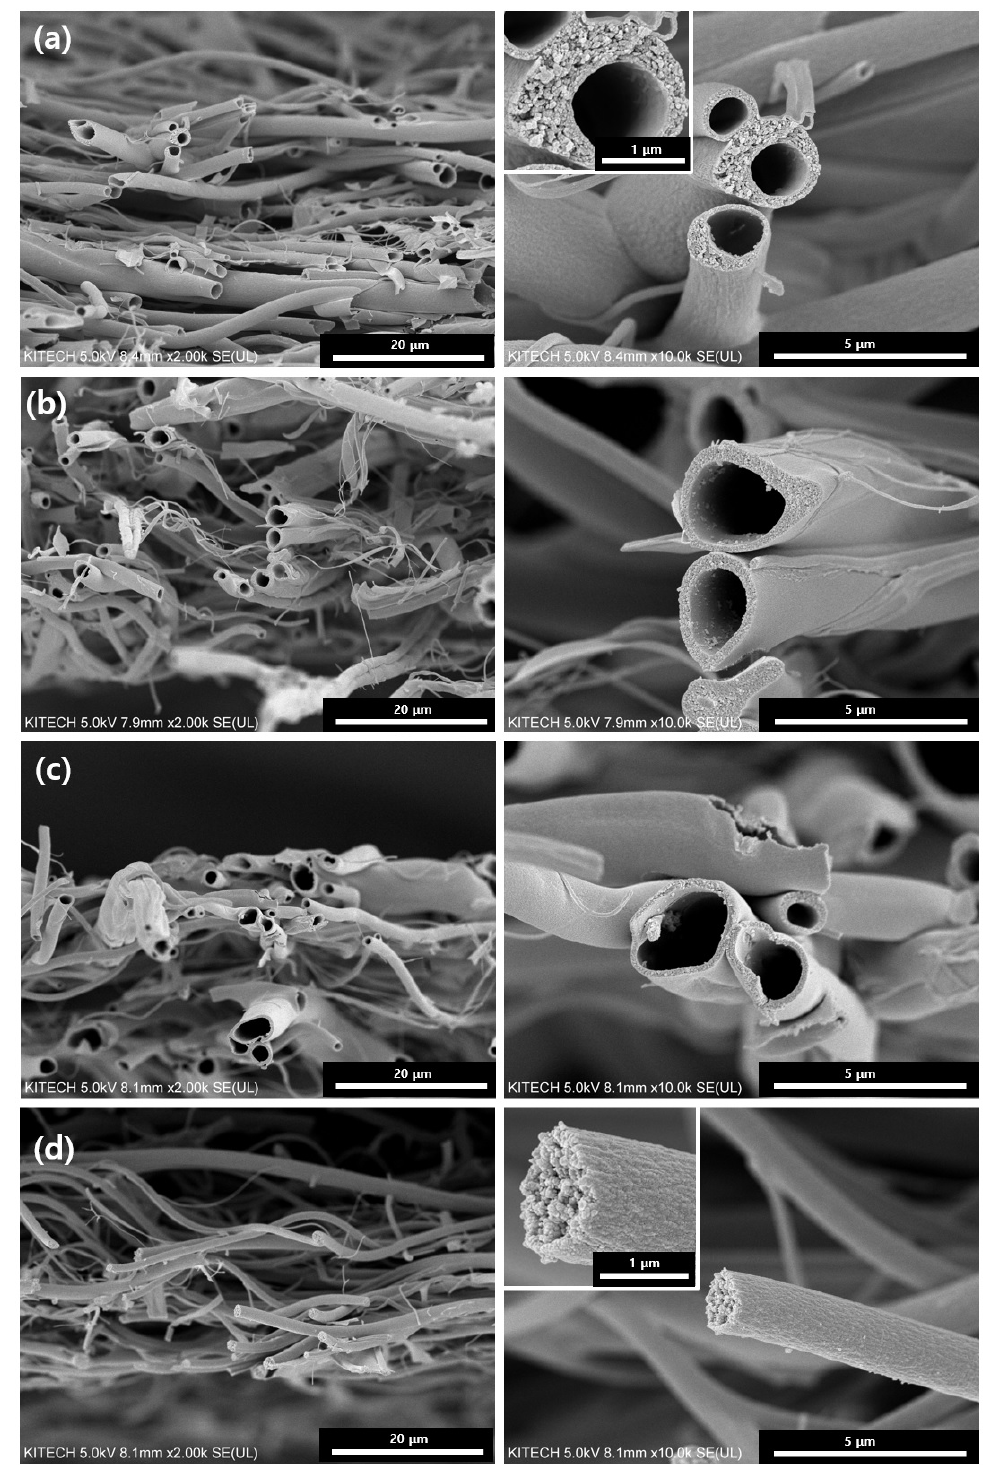
Figure 3. SEM images of hollow and solid TiO 2 fibers after calcination: ( a ) TiO 2 @C1, ( b ) TiO 2 @C2, ( c ) TiO 2 @C3, and ( d ) TiO 2 @C0.